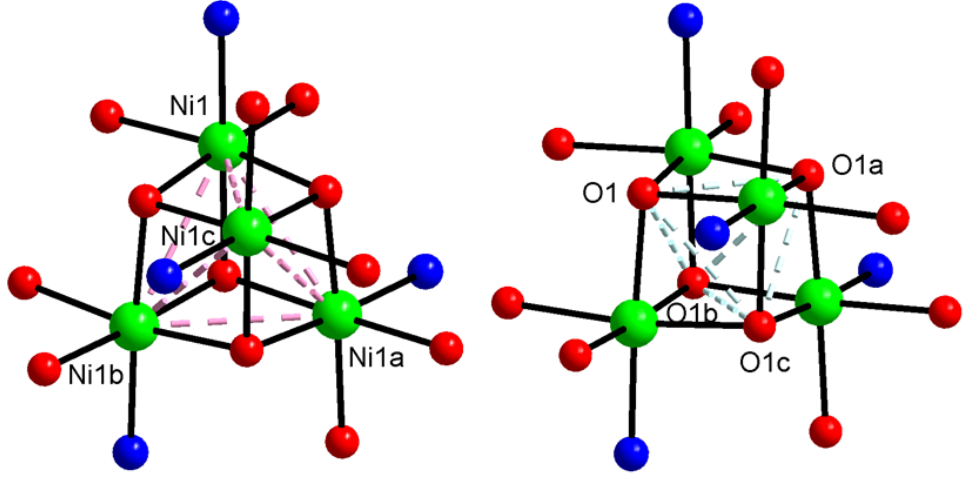
Figure 3. Interpenetrated tetrahedral set of four Ni(II) centers and four O1 donors by four µ 3 -O- methanolate ligands, as primary driving force in the building of the tetranuclear core of 1 .